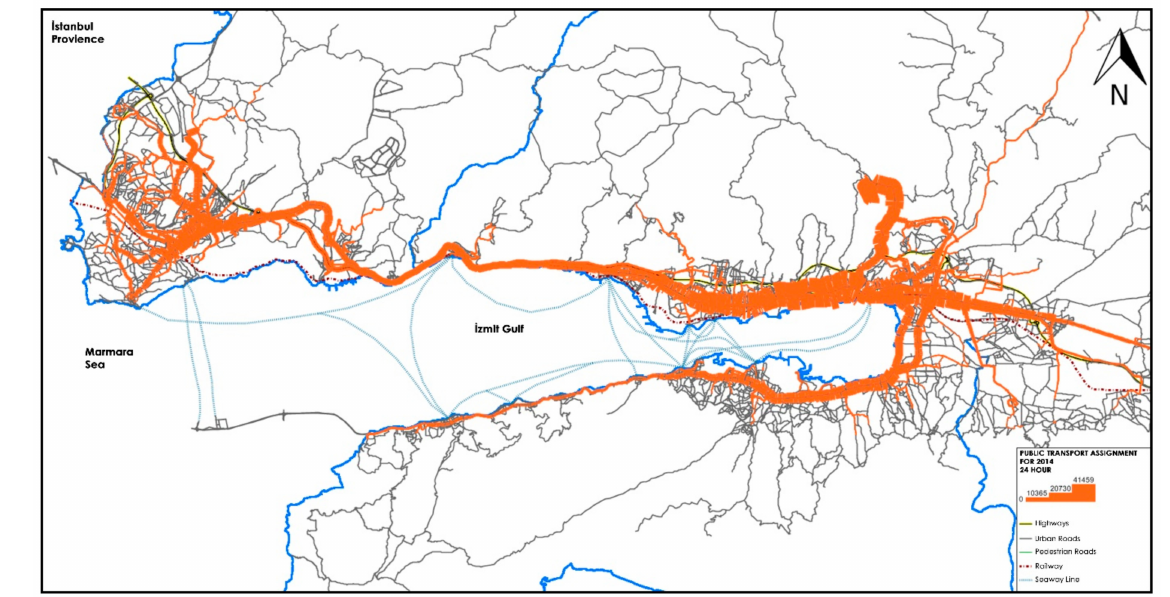
Figure 1. Public transport (PT) network assignment in our study area; Kocaeli metropolitan